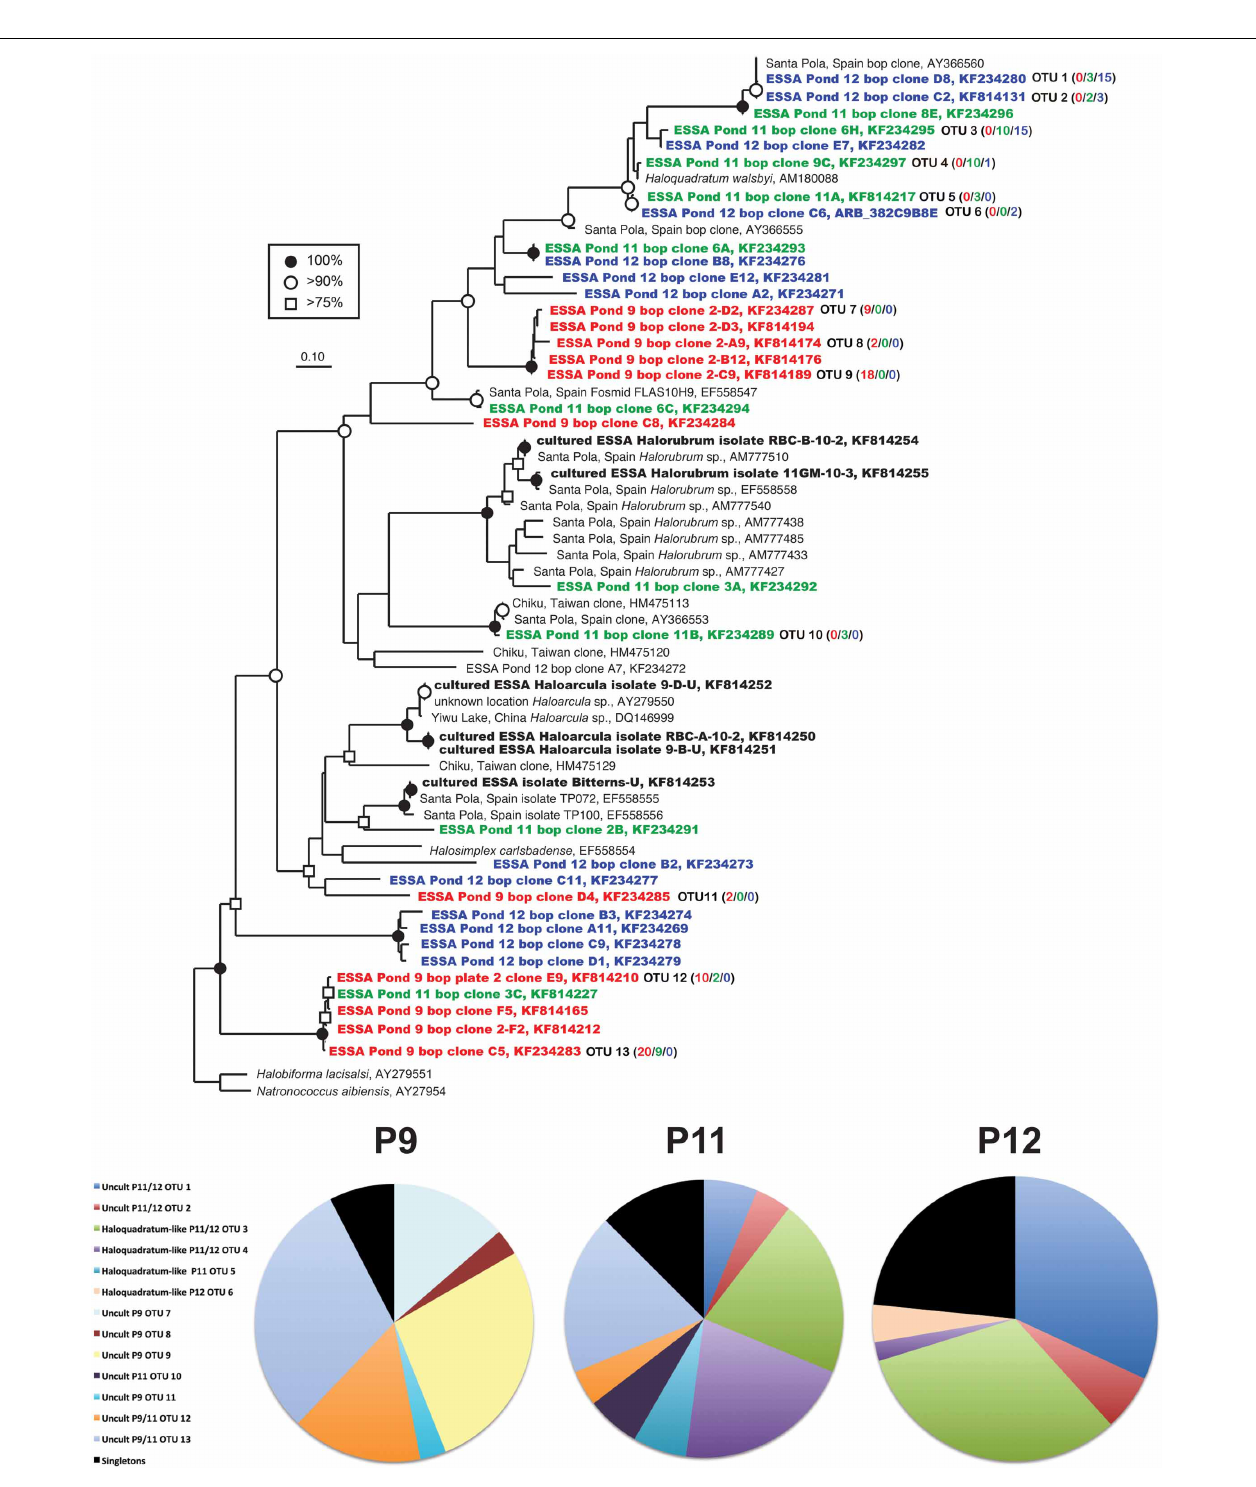
FIGURE 4 | Unrooted maximum likelihood dendrogram depicting relationships among representative bop gene sequences at the 1% evolutionary difference level for clones obtained from the Ponds 9 (red), 11 (green), and 12 (blue), ESSA cultures (bold) and closely related sequences. The tree was constructed using an alignment of 312 nucleotide positions (gaps and ambiguous residues were excluded using a custom filter in ARB). Symbols at branches represent nodes with bootstrap support ≥ 75%